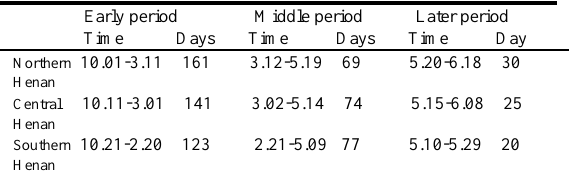
Table 1. Division of winter wheat growth period in Henan Province research